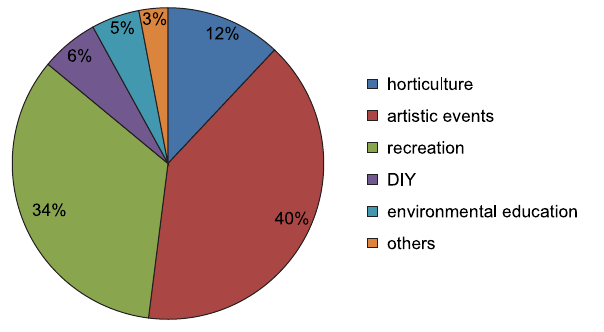
Fig. 6. Types of events in the Łazarz Garden